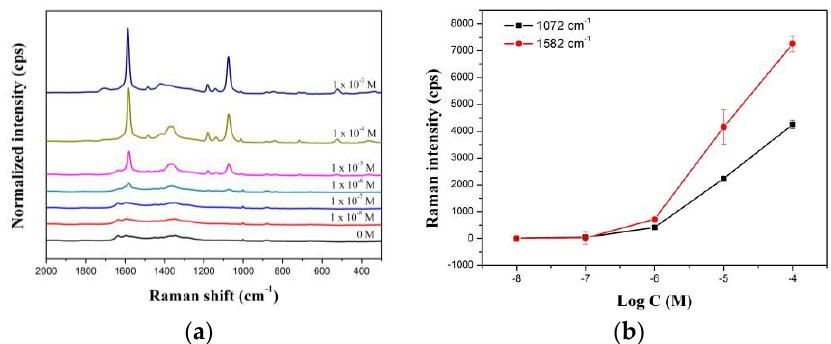
Figure 4. ( a ) SERS spectra and ( b ) calibration curves of GO@SiO 2 @Ag NPs to different 4- mercaptobenzoic acid in EtOH solution. Laser power is 10 mW, wavelength is 532 nm, integration time is 5 s, and the laser spot is 2